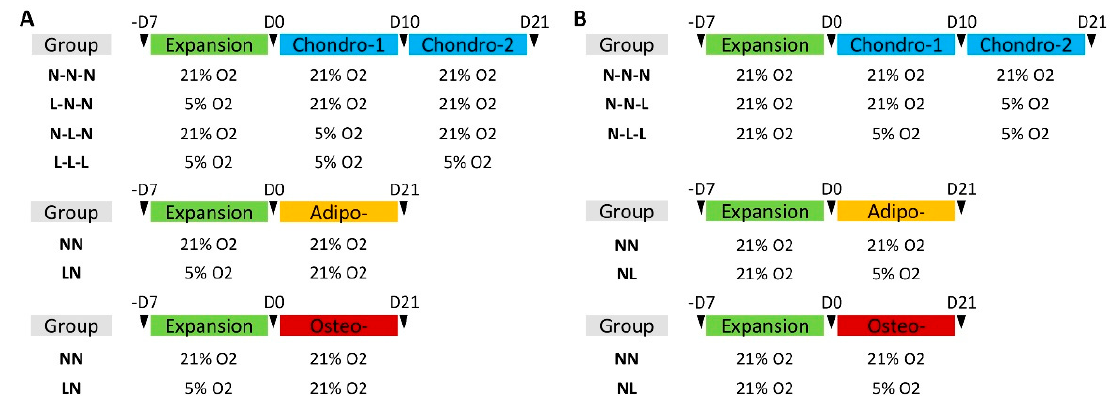
Figure 1. Schematic of Experimental Design. Both fetal NPCs and SDSCs were expanded in T175 plastic flasks for 7 days followed by either two phases of chondrogenic differentiation (D0-D10, D10- D21) in a pellet culture system, or one phase of either adipogenic or osteogenic differentiation (D0- D21) in T25 plastic flasks. ( A ) The pretreatment culture regimen was designed to subject each chon- drogenic cell type to four treatment conditions that vary in oxygen tension (N-N-N, L-N-N, N-L-N, and L-L-L). Adipogenic and Osteogenic cells were subject to hypoxia or normoxia during expansion